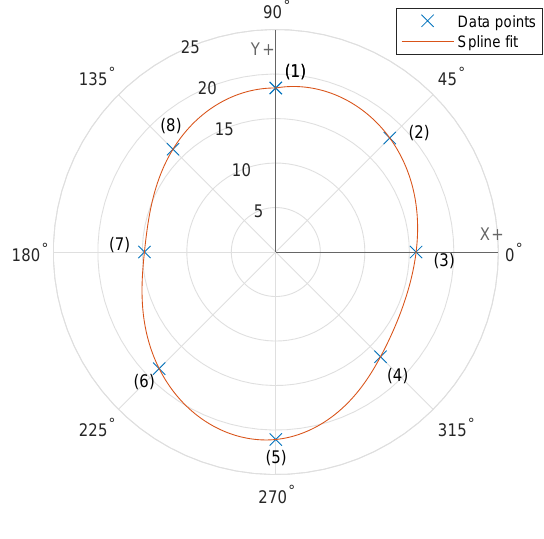
Figure 16: 3-axis CNC, test 1.3: polar plot with av- erage stiffness in the xy-plane at different directions (see Fig 5) ( N / (cid:181) m ).